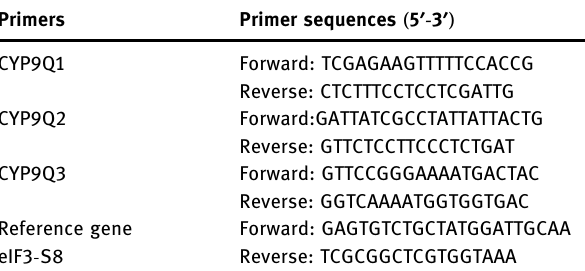
Table 1: Sequences of primers of genes encoding cytochrome P450 isoenzymes belonging to the CYP3 family involved in detoxi fi cation – CYP9Q1, CYP9Q2, and CYP9Q3 [ 23 ]